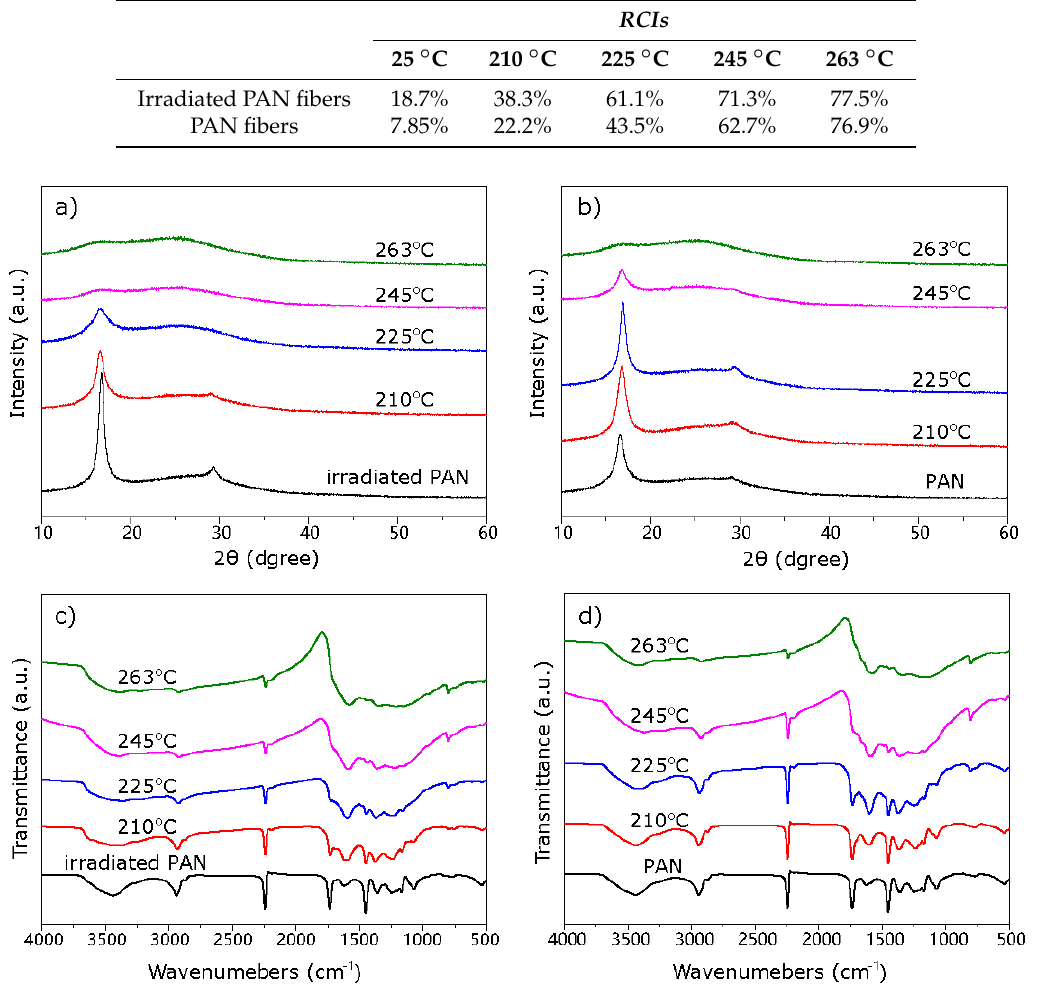
Figure 5. XRD patterns of ( a ) irradiated PAN fibers and ( b ) PAN fibers; FI-IR spectra of ( c ) irradiated PAN fibers and ( d ) PAN fibers at various stages of stabilization.